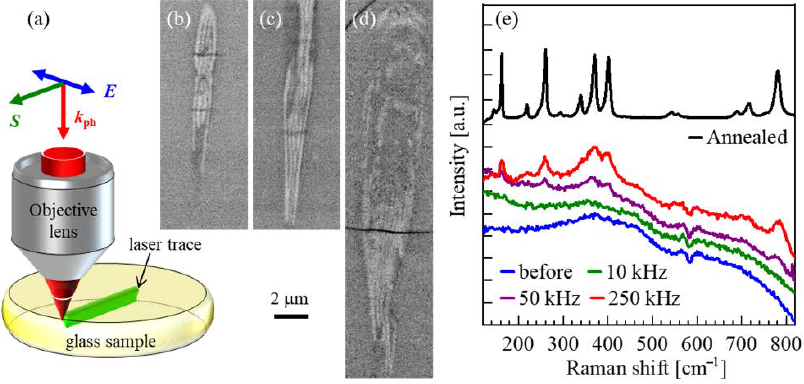
Figure 3. ( a ) Schematic indicating the orientation of the laser propagation, polarization direction and writing direction. Symbols of k ph , E and S indicate the orientation of the laser propagation, polarization direction and writing direction, respectively. Backscattering electron images on the polished sample in the plane perpendicular to the laser traces written by the femtosecond laser pulses with ( b ) 10 kHz, ( c ) 50 kHz, and ( d ) 250 kHz. The laser parameters were as follows: 800 nm, 40 fs, 1.0 µJ, 10,000 pulse/µm, 0.80 NA. ( e ) Raman spectra of the prepared 62.5Al 2 O 3 -37.5Y 2 O 3 glass samples before and after laser irradiation with various pulse repetition rate. The reference Raman spectrum of the Y 3 Al 5 O 12 crystal precipitated by annealing of undoped YAG glass is also shown.